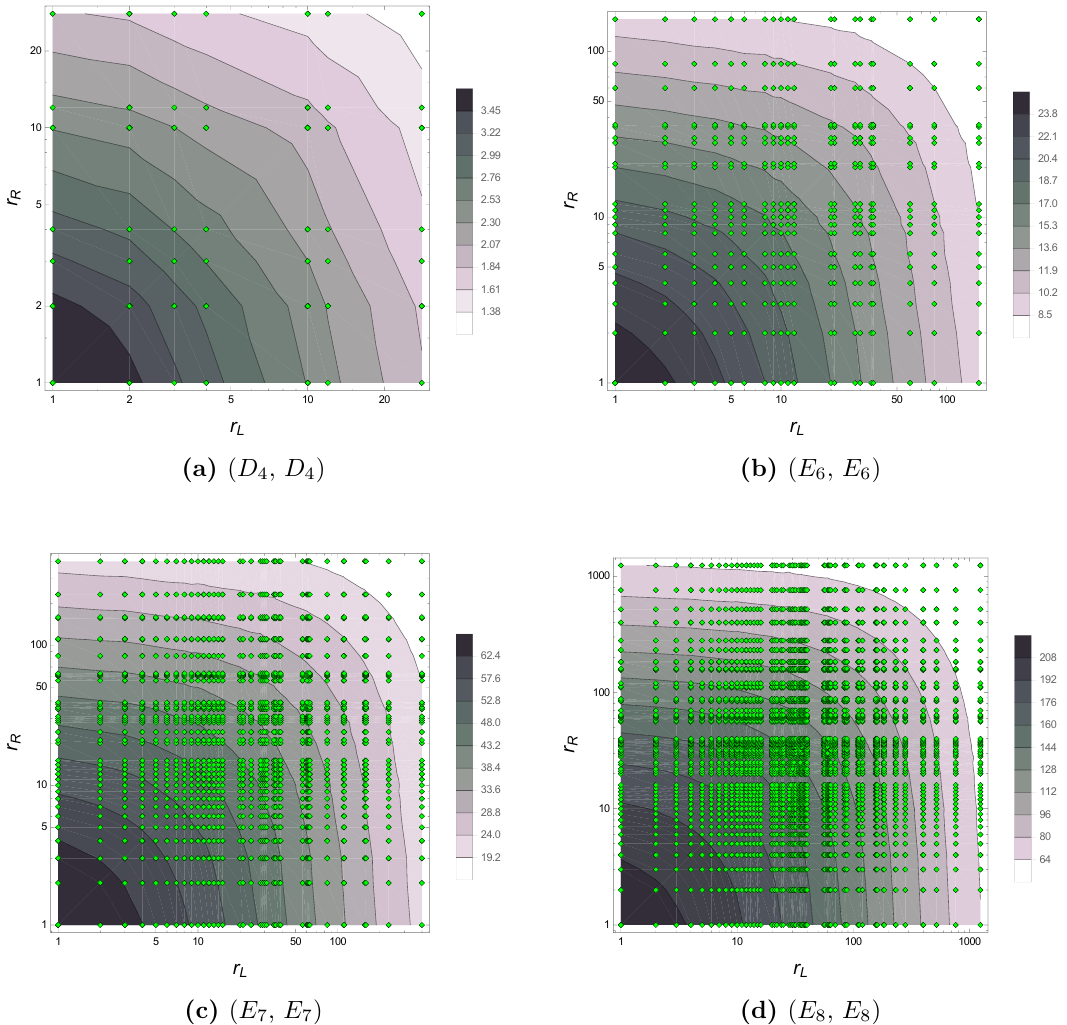
Figure 10. Plots of a IR vs left and right embedding indices for the di(cid:11)erent conformal matter theories, with (cid:13)ipper (cid:12)eld deformations. The contour plots are obtain by extrapolating between the actual data points which are labelled in